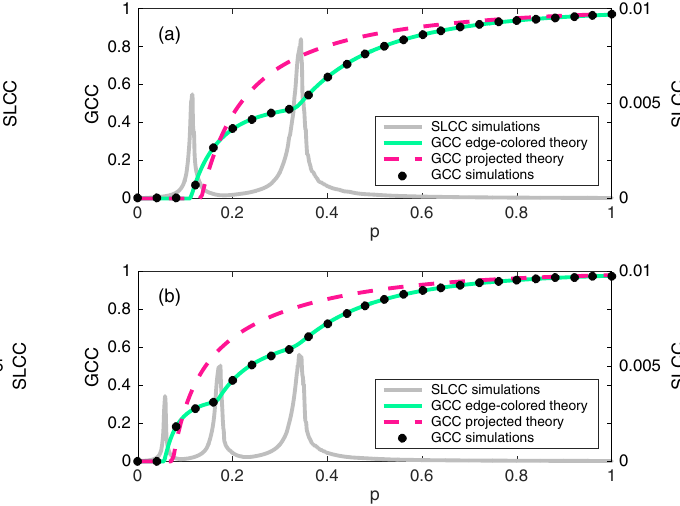
FIG. 1. Expected size of the GCC as a function of p for (a) a maximally correlated two-layer multiplex network made of two Poisson random networks and (b) an uncorrelated three-layer multiplex network made of one Poisson random network and two scale-free networks. Numerical simulations are averaged over 100 realizations, and N ¼ 10 5 . Peaks in the expected size of the SLCC indicate percolation